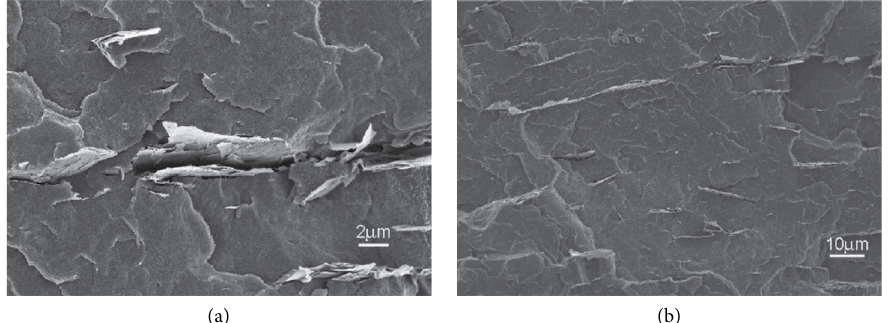
Figure 1: SEM images of (a) expanded graphite (EG)-PVDF and (b) functionalized graphene sheets (FGS)-PVDF showing the surface integrality. Adapted from